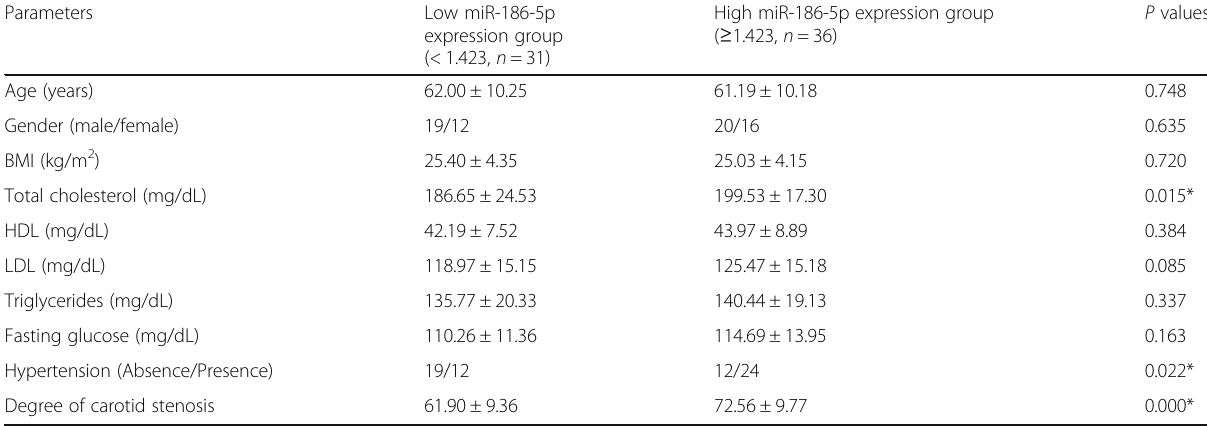
Table 2 Association of miR-186-5p with the clinical data of asymptomatic CAS patients Parameters